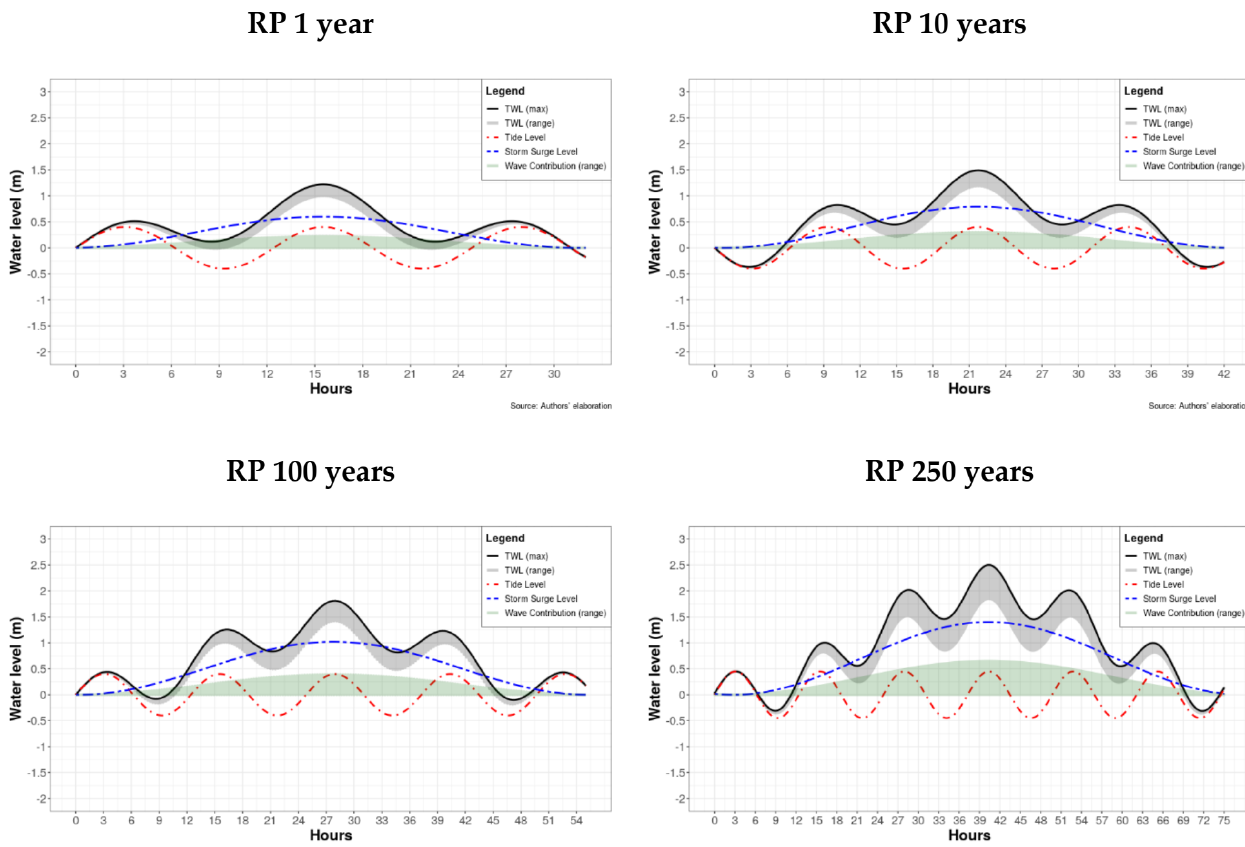
Figure A1. Dynamic boundary conditions for simulating theoretical extreme sea level events in ANUGA. The total water level is shown as the grey-shaded area, while the maximum total water level is shown by the black line at any given time. The tide (dashed red line), storm surge (dashed blue line) and wave contribution (green-shaded area) components define the total water level. Configurations are shown for the return periods of once in 1, 10, 100 and 250